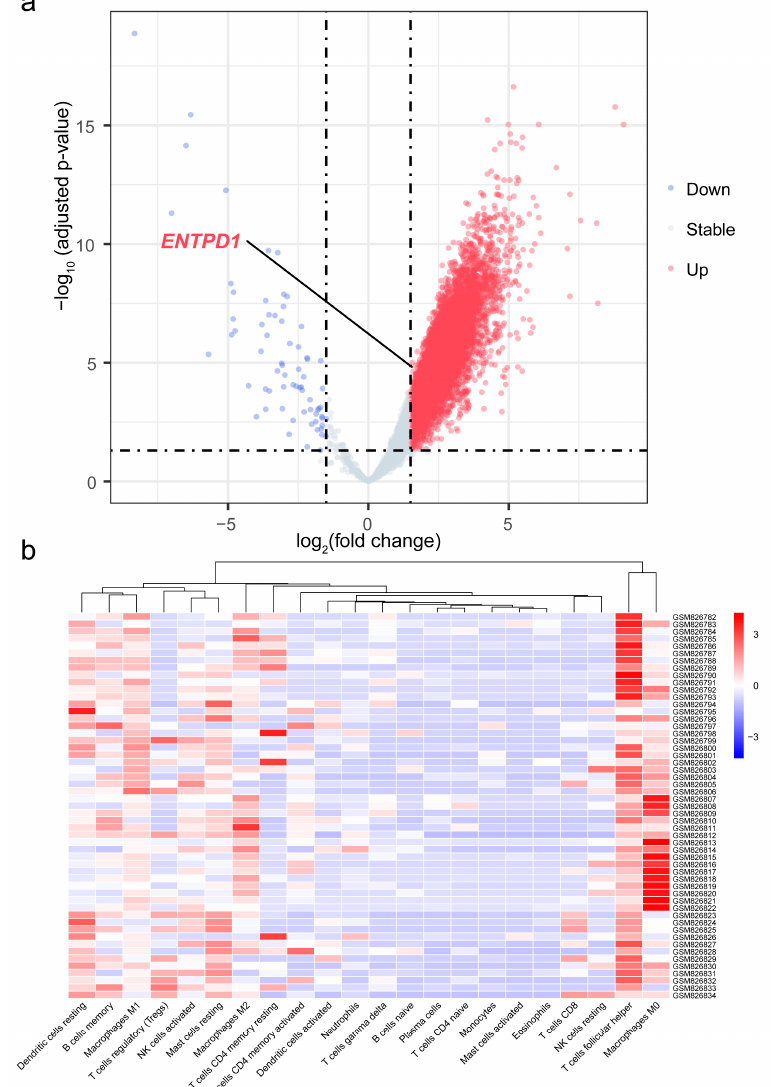
Figure 6. Volcano plot of differential gene expression analysis and heatmap of infiltration abundance of 22 immune cells. ( a ) Volcano plot of differential gene expression analysis of 41 ESCC and 12 normal tissues samples; ( b ) Heatmap of infiltration abundance of 22 immune cells of 41 ESCC and 12 normal tissues samples. ENTPD1 , ectonucleoside triphosphate diphosphohydrolase